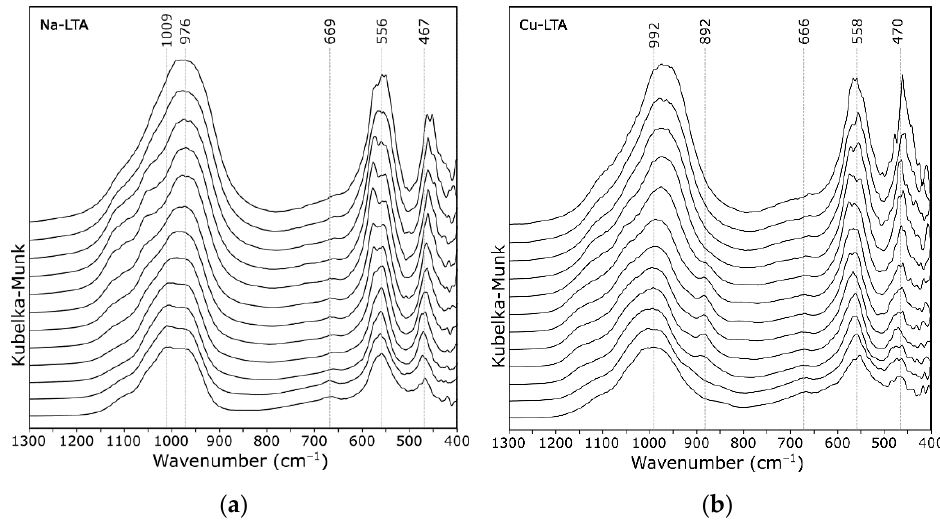
Figure 6. DRIFT spectra of zeolite A recorded at 50 °C intervals (from 50 to 600 °C): ( a ) Na-A; and